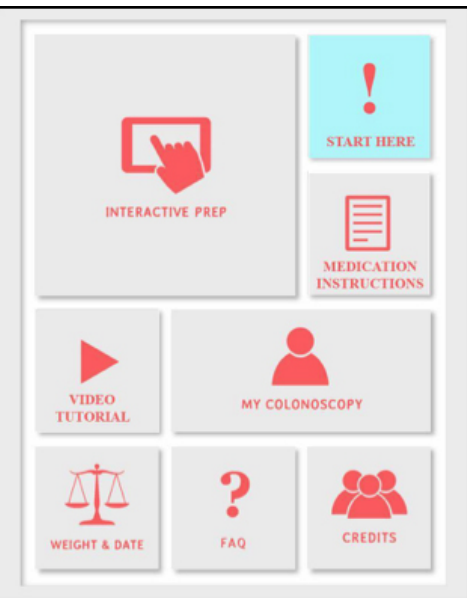
Figure 1. The home screen of the SB Colonoscopy Prep app.